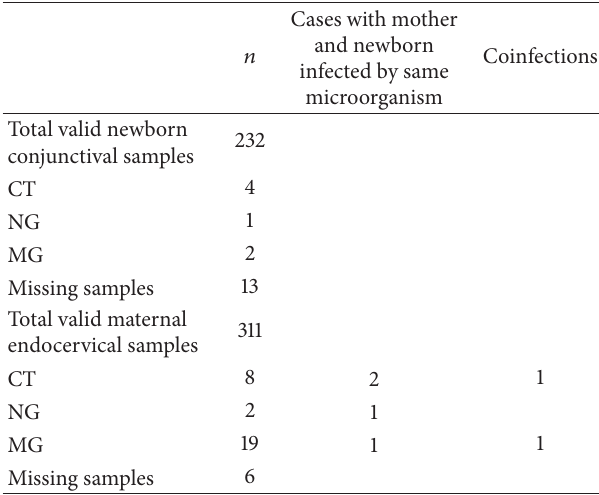
Table 2: PCR-based diagnosis of infectious